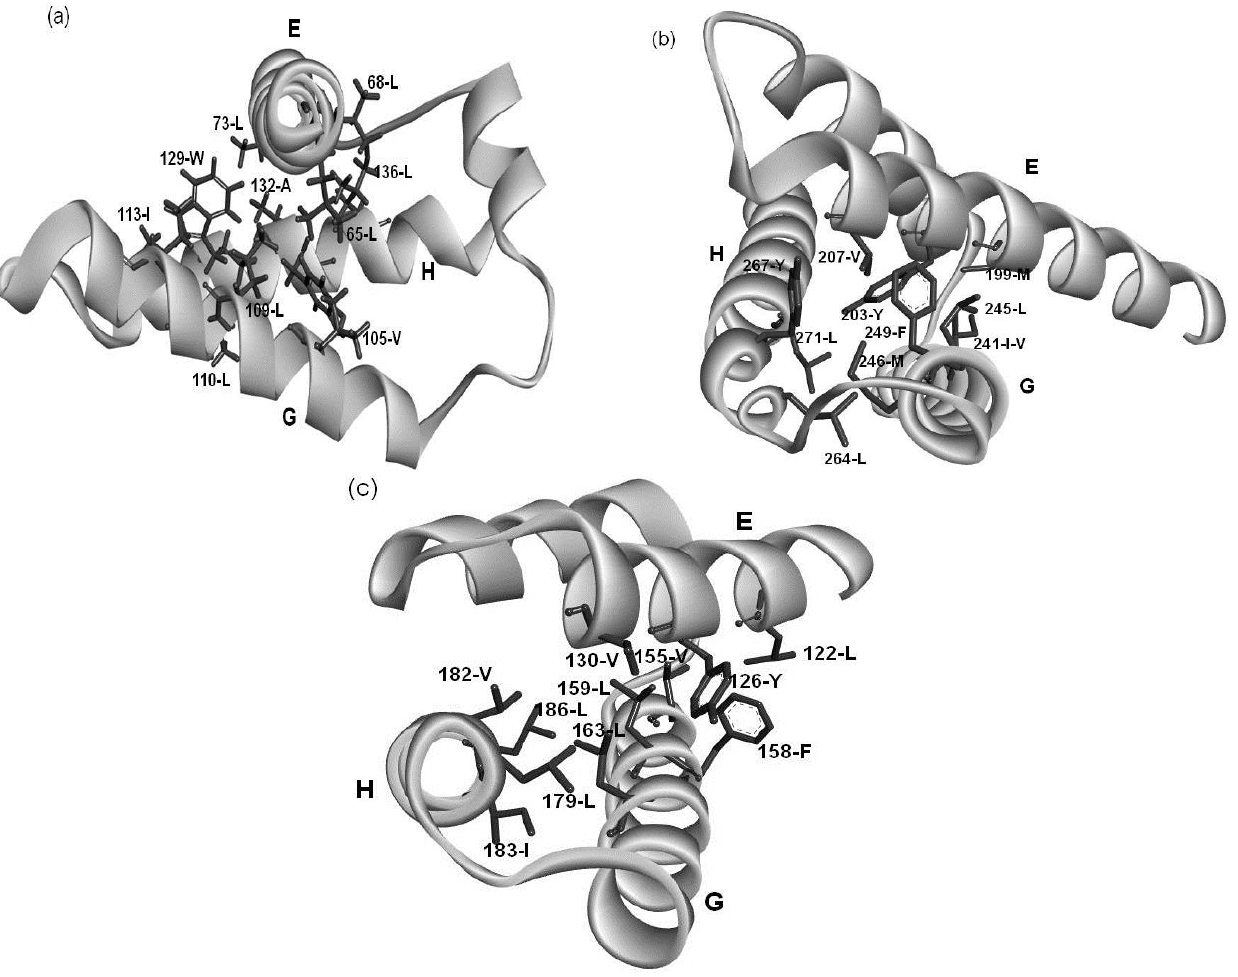
Figure 9. The hydrophobic packing formed by residues of the common patterns in ( a ) 1FSL; ( b ) 1R8J and ( c )